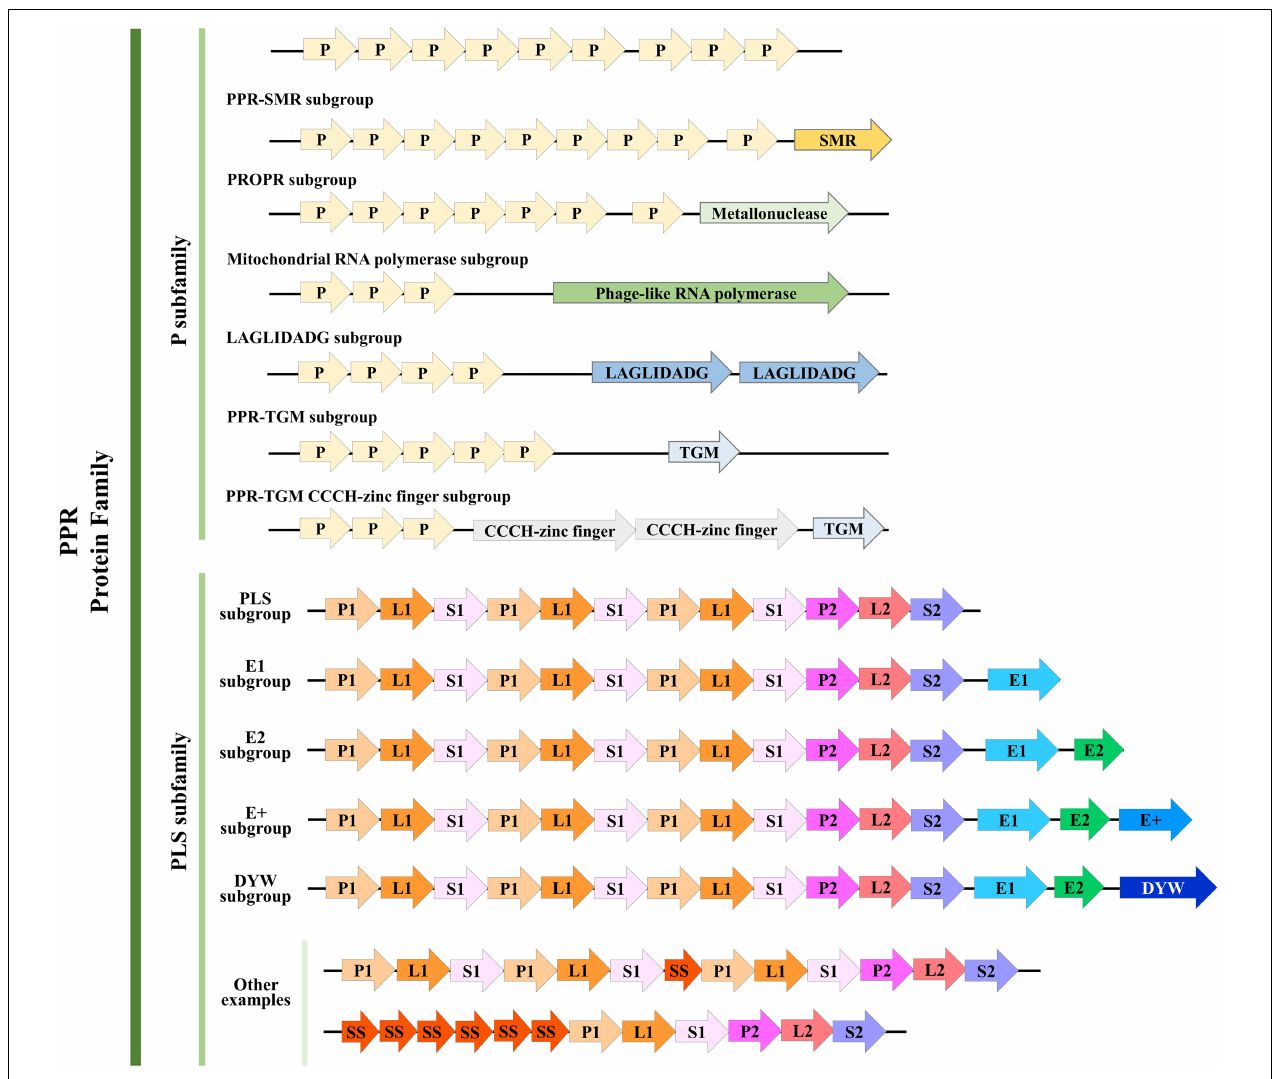
FIGURE 1 | Structure of pentatricopeptide repeat (PPR) proteins. Refined classification and motif structure of PPR proteins (modified from Manna, 2015 and Cheng et al., 2016). The PPR family can be further classified into two subfamilies, P and PLS. P subfamily proteins consist of one or more tandem arrays of P motifs; whereas PLS subfamily proteins consist of triplets of P, L, and S motifs, occasionally interspersed with additional S motifs (P, L, and S can be further divided as we described above). A few P-class proteins contain additional motifs, such as the SMR, TGM, TGM CCCH-zinc finger, LAGLIDADG, Mitochondrial RNA polymerase, and PRORP. Almost all PLS-class proteins contain C-terminal E motifs (E1, E2, and E+; E+ motif was defined by Cheng et al., 2016), and many contain, in addition, a DYW motif. Some other examples that belong to the PLS subfamily were shown here. Arrows with different colors represent different motifs. Numbers of PPR motifs shown in each subgroup do not represent all members, and the motifs are not to